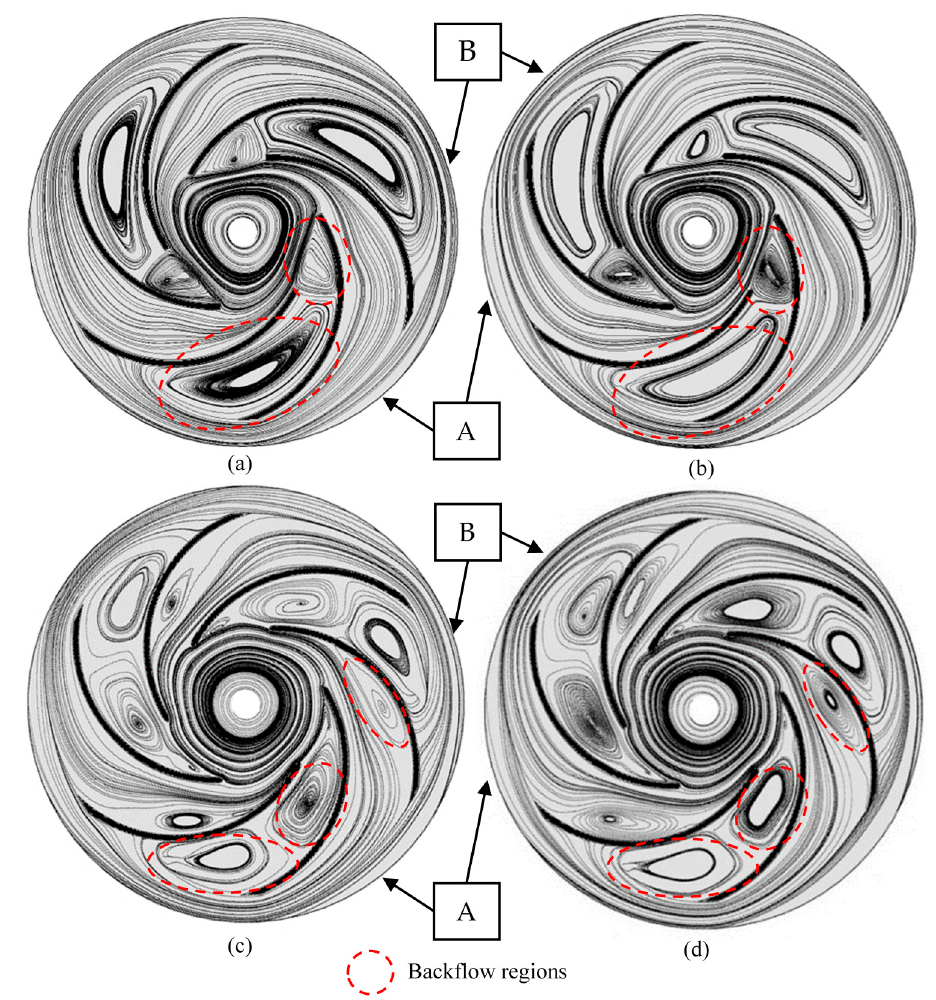
Figure 8. Streamlines of the alternating stall patterns in the impellers with different leading-edge shape: ( a ) blunt, ( b ) sharp, ( c ) round, and ( d ) ellipse.